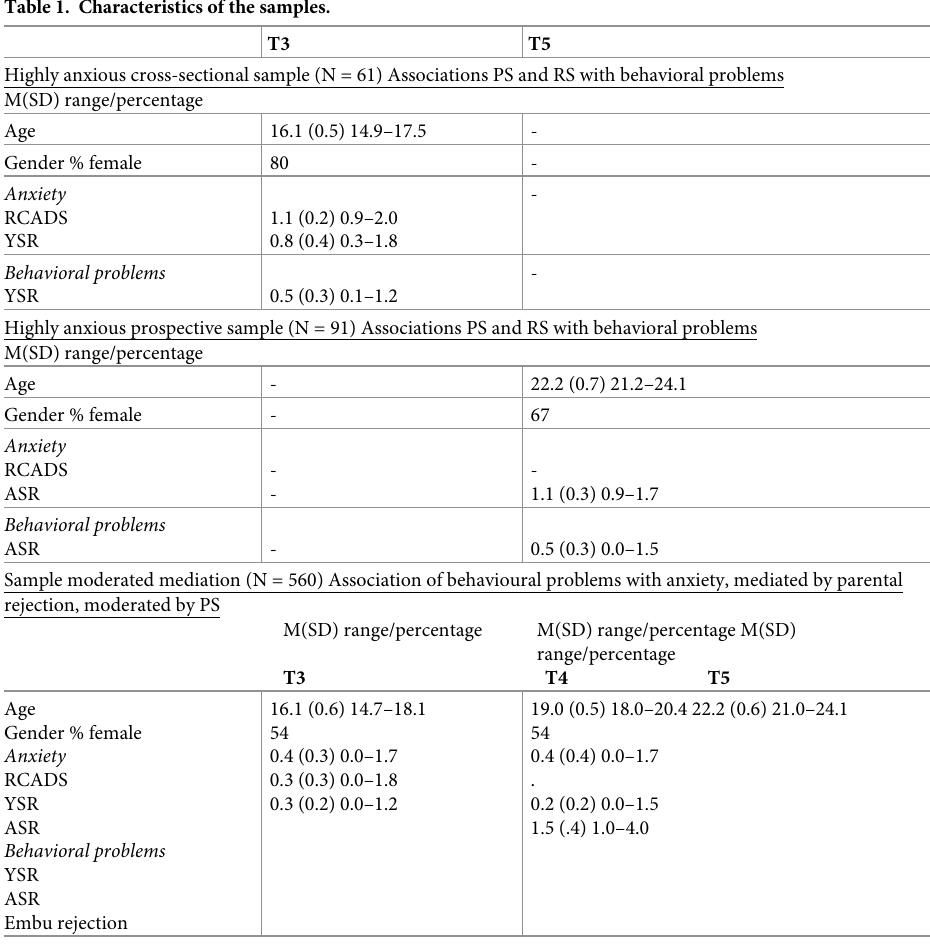
Self Report. PS = attentional proneness components of punishment